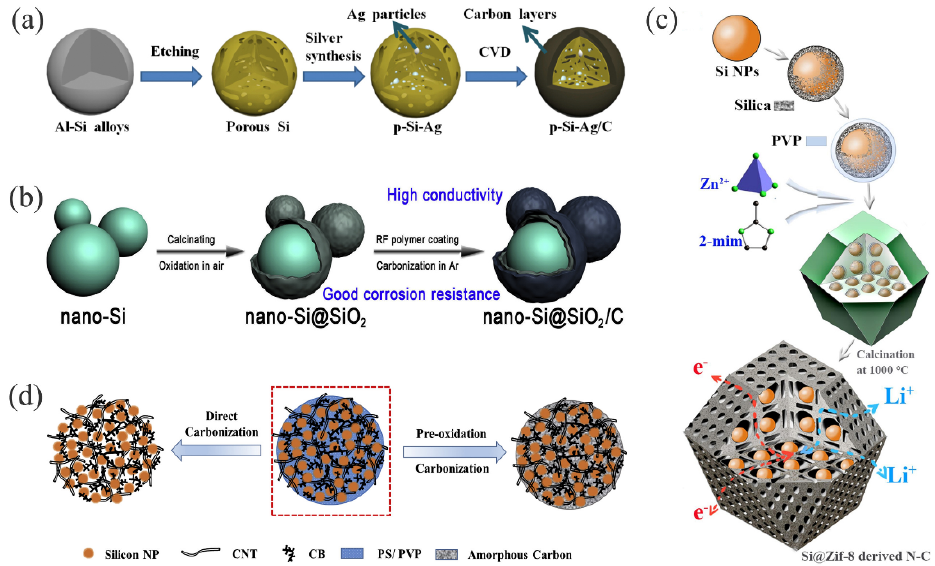
Figure 3. Schematic diagram of the different structures of Si–C composites: ( a ) coated core-shell structure [77]. Reprinted with permission from Ref. [77]. Copyright 2018, J. Power Sources. ( b ) hollow core-shell structure [78]. Reprinted with permission from Ref. [78]. Copyright 2018, J. Alloys Compd. ( c ) porous structure [79]. Reprinted with permission from Ref. [79]. Copyright 2020, Appl. Surf. Sci. ( d ) embedded structure [80]. Reprinted with permission from Ref. [80]. Copyright 2018, Carbon.